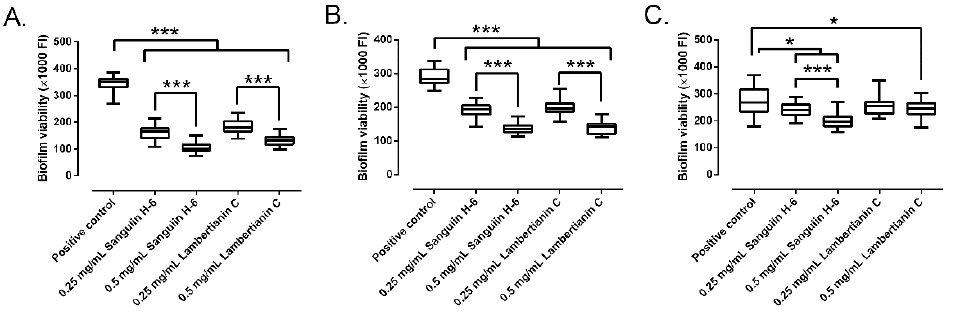
Figure 6. The effect of sanguiin H-6 and lambertianin C at different concentration on growth of